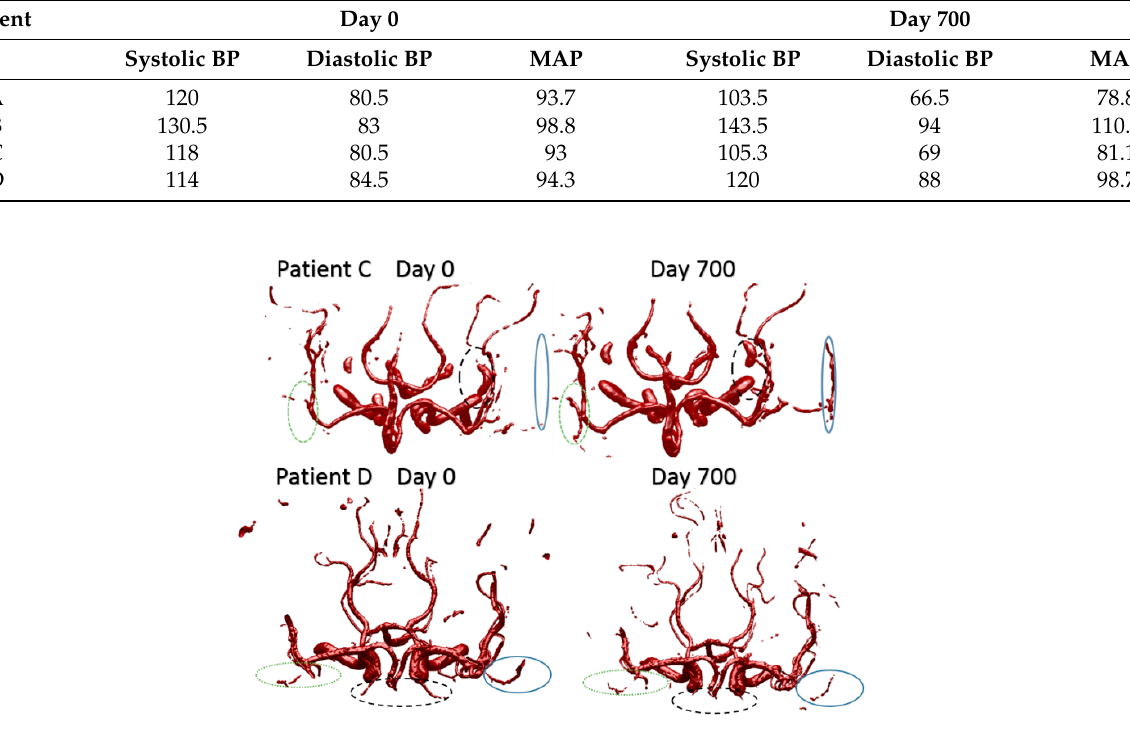
Figure 6. Applying a 3D growing algorithm to the volume of binary segmented images allows for visualization of the automatically segmented MRA data. Day 0 of patient C (top left). Day 700 of patient C (top right). Day 0 of patient D (bottom left). Day 700 of patient D (bottom right). The correlation between the CDF and MAP was not found in these patients. Some apparent differences between vascular constructions in areas below the circle of Willis are highlighted.